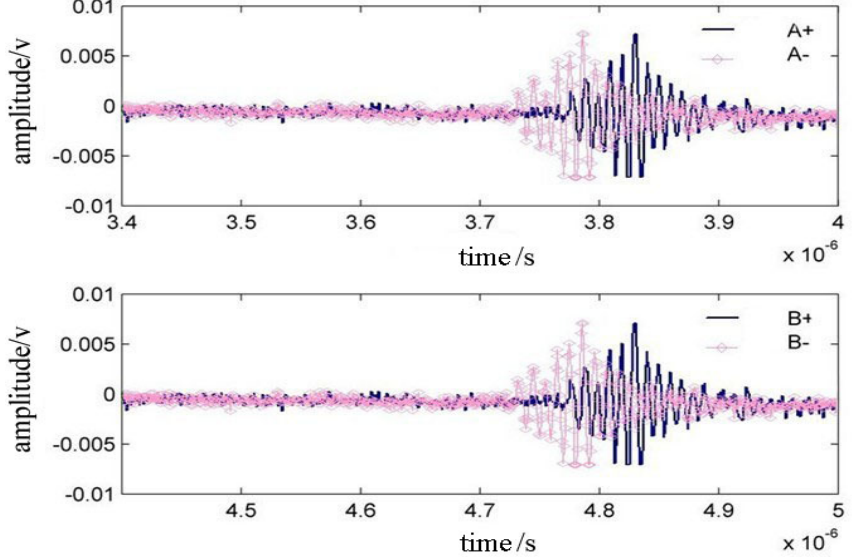
Figure 6. Waveform in time domain when the detecting line deviates 1 degree.